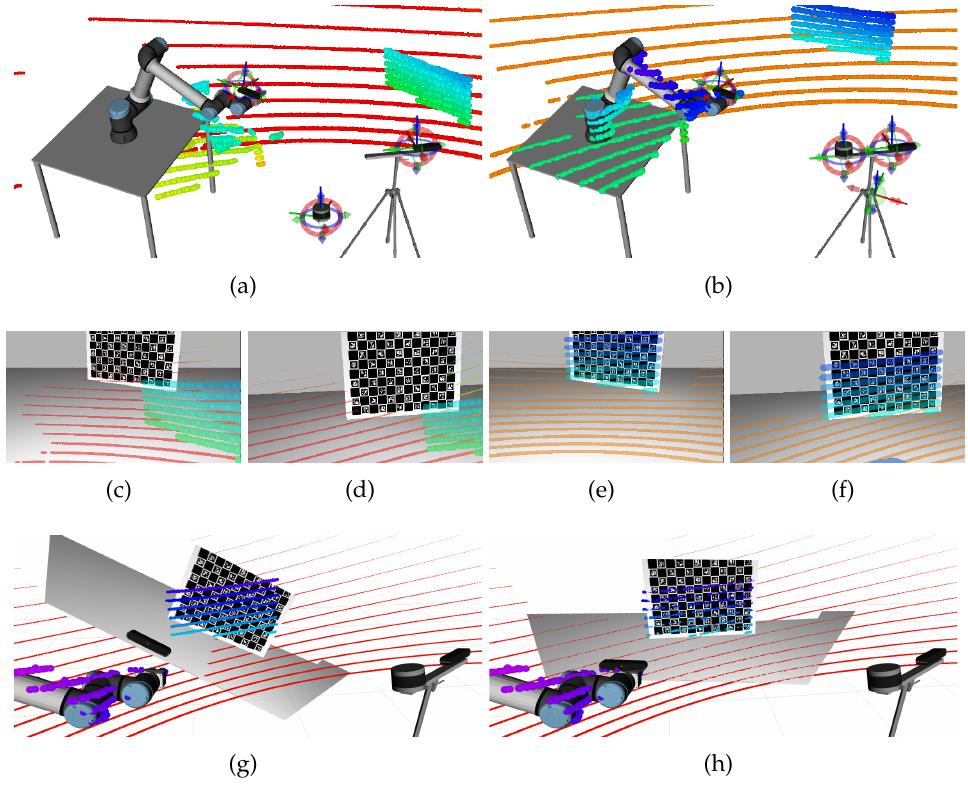
Figure 6. Setting an initial estimate for the sensor poses using RViz interactive markers. Top two rows: Inaccurate (left side) vs accurate (right side) positioning of the 3d LiDAR sensor. On the left side, the 3D points from the pattern (the blue-green spheres in ( a )) do not align well with the pattern of the images of the world camera ( c ) and the hand camera ( d ) images. The right side shows how an accurate positioning of the sensor aligns the projection of the 3D LiDAR measurements (blue spheres in ( b )) with the pattern in the images of the world camera ( e ) and the hand camera ( f ). Bottom row: inaccurate (left) vs accurate (right) positioning of an RGB-D camera. In ( g ), the point cloud produced by the RGB-D camera (points textured with real colors) is misaligned with LiDAR point cloud (red to blue spheres). In ( h ), a correct positioning of the RGB-D camera produces a good alignment between point clouds.